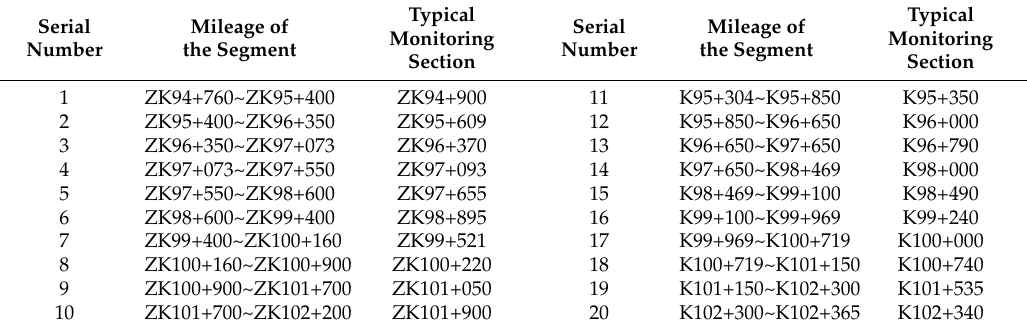
Table 1. Segment classification and typical monitoring sections in Cang Ling Tunnel.